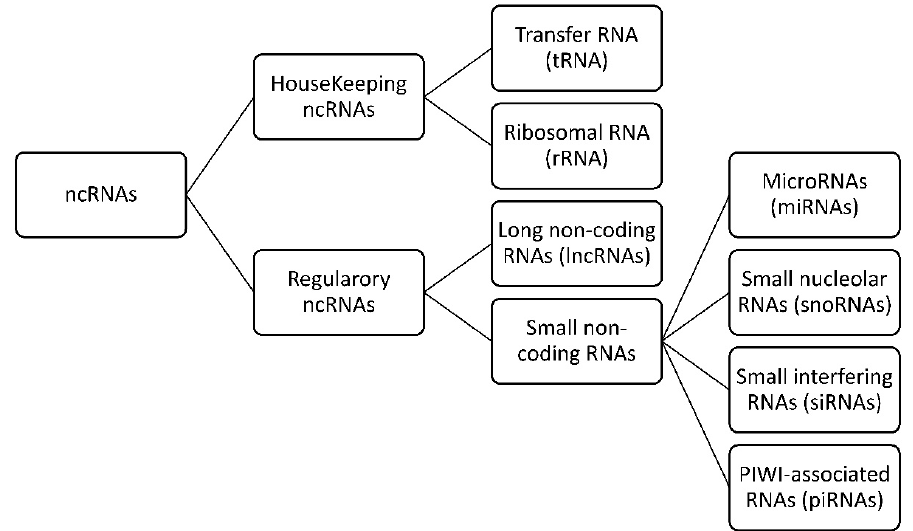
Figure 1. ncRNA categories. RNAs are divided into two major classes: messenger RNA (mRNA) and non ‐ coding RNA (ncRNA).